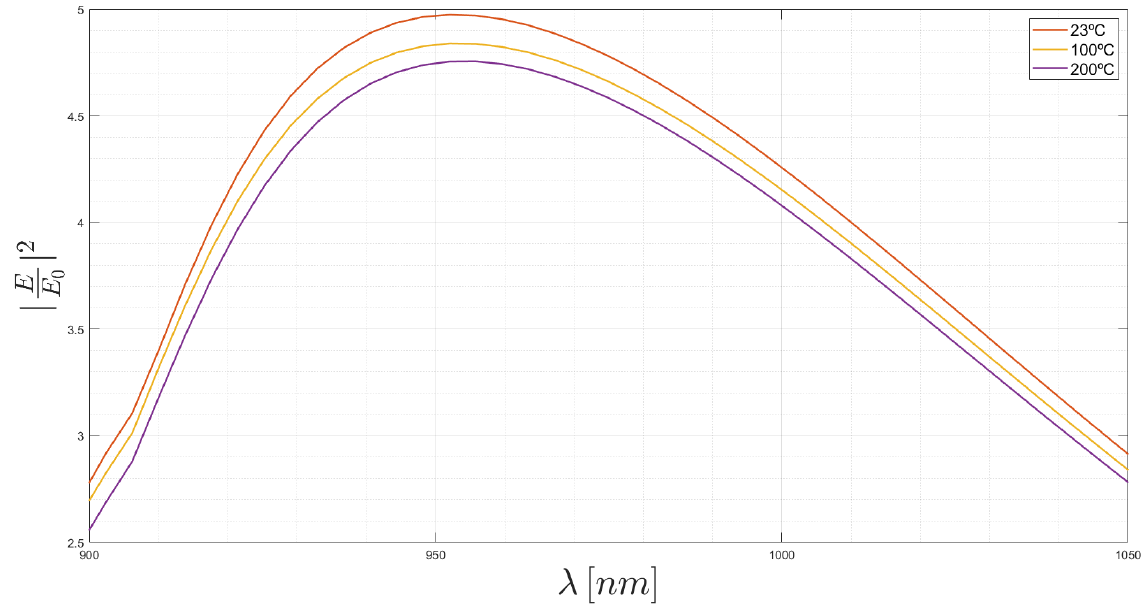
Figure 13. Gold nanostructure response for different temperatures below the critical